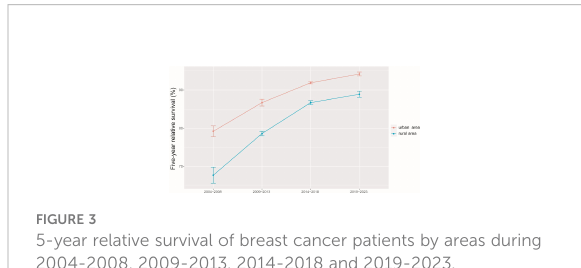
FIGURE 3 5-year relative survival of breast cancer patients by areas during 2004-2008, 2009-2013, 2014-2018 and